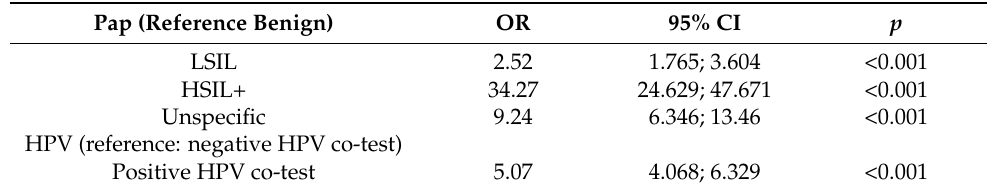
Table 5. Generalized Estimating Equation (GEE) Model with HPV and a Positive HPV Co-test as an Independent Predictor.